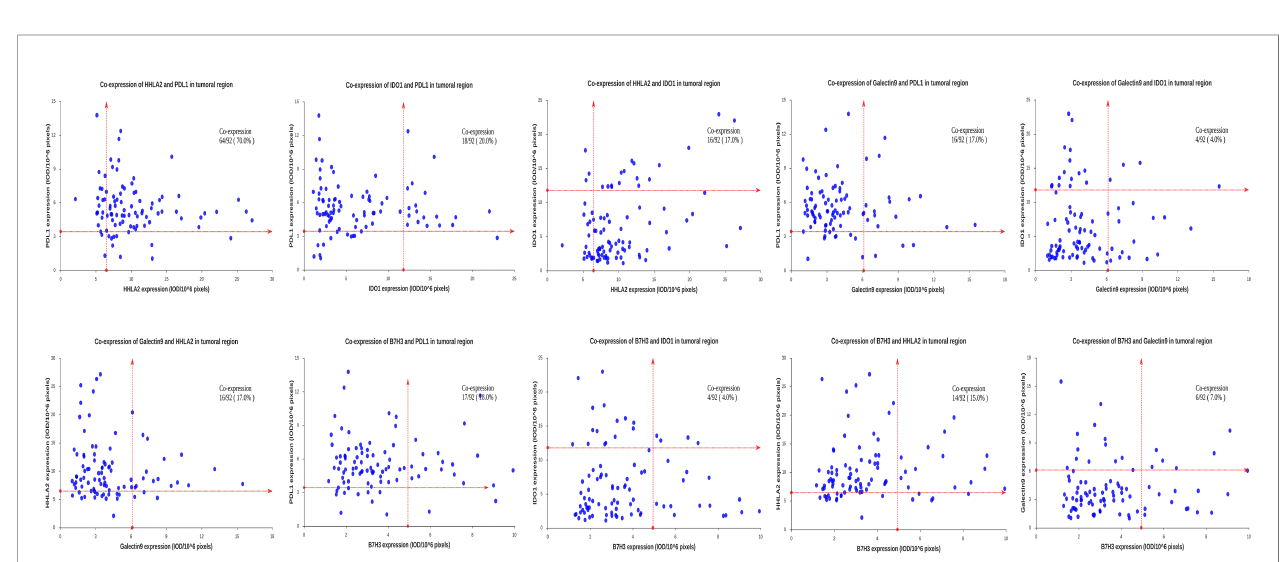
FIGURE 6 | Representative fl uorescence pictures show coexpression between immune checkpoints in human spinal chordoma. The white arrows indicate the coexpression of immune markers. The target protein is indicated in different fl uorescence channels, and tumor cells are highlighted with CK-19. Nuclei are stained with DAPI. Scale bar = 100 m m.